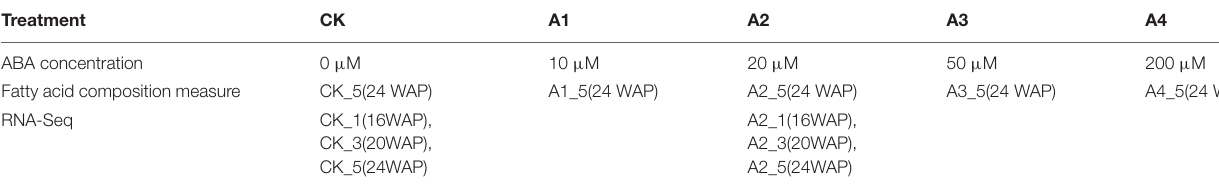
TABLE 1 | Treatment and sampling